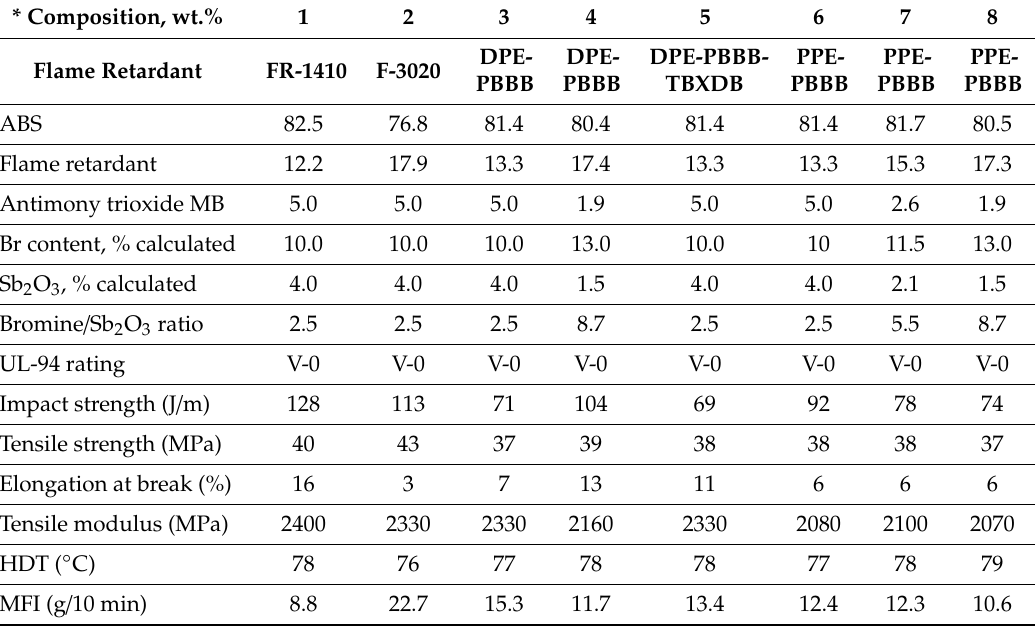
Table 4. Flammability performance and physical properties of ABS